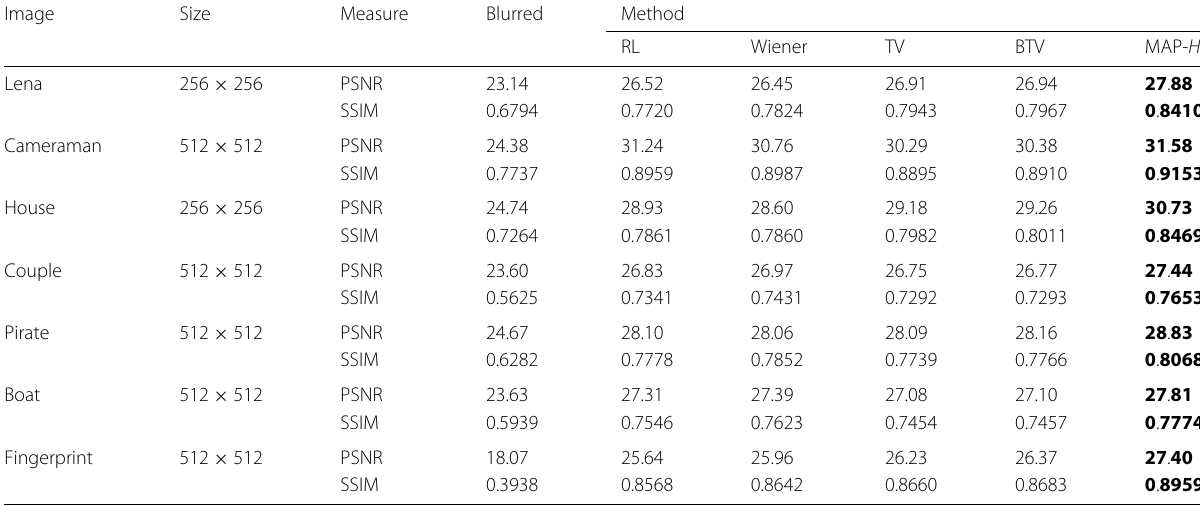
Table 2 PSNR and SSIM values obtained by five methods for seven different images degraded by kernel 2 Image Size Measure Blurred Method